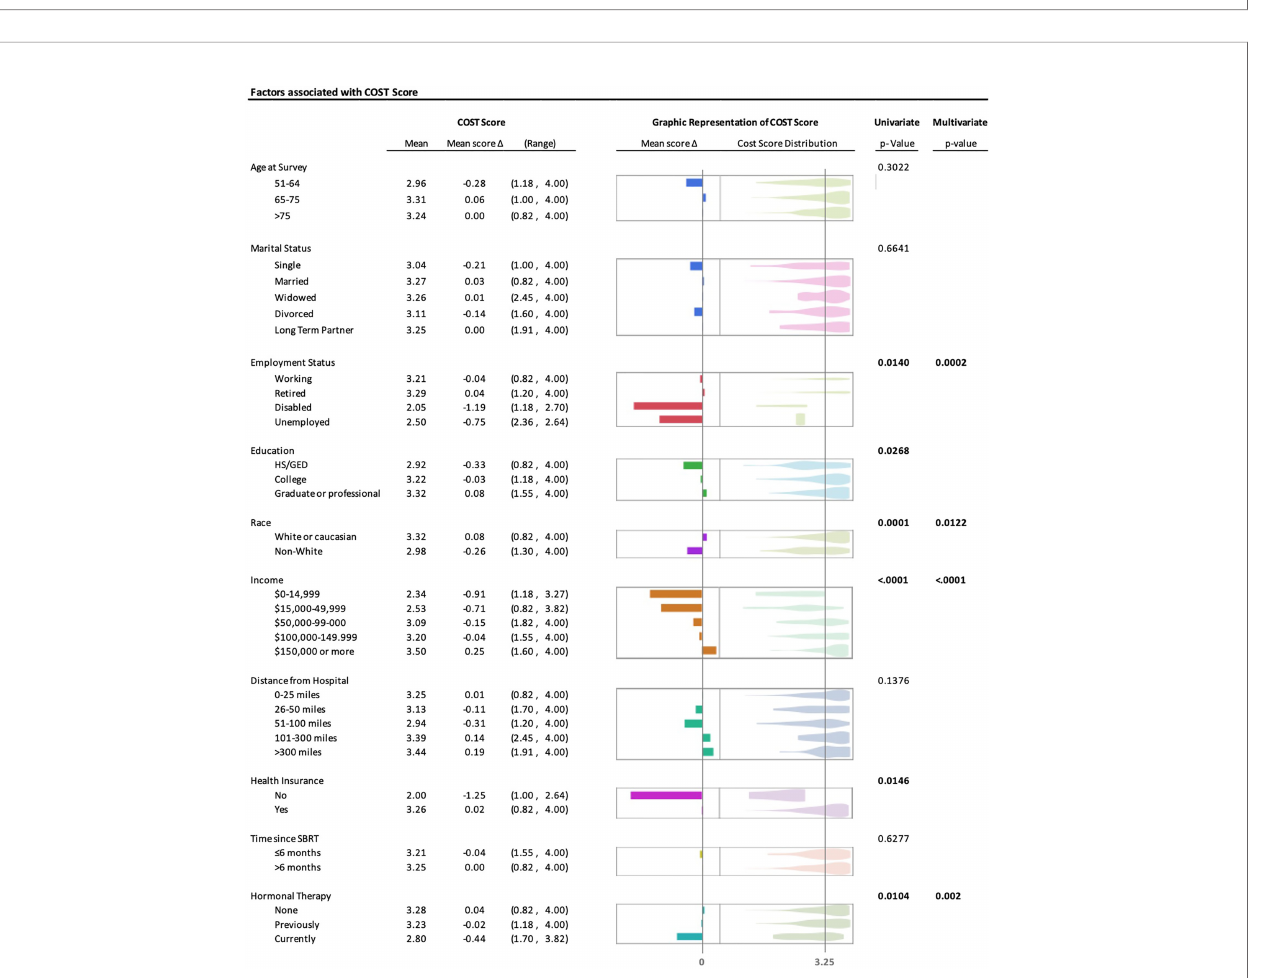
FIGURE 1 | COST Grade toxicity distribution by proportion of population.